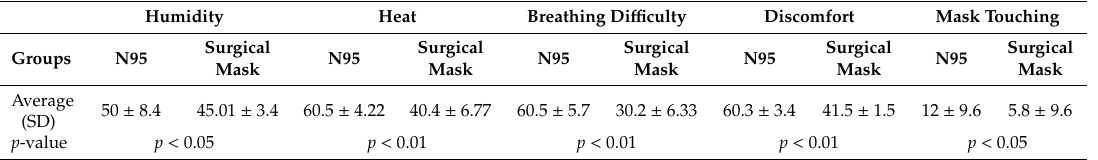
Table 1. Summary of the mask touching frequency, humidity, heat, breath di ffi culty, and discomfort rate between the two groups (mean, SD. Student’s t -test).